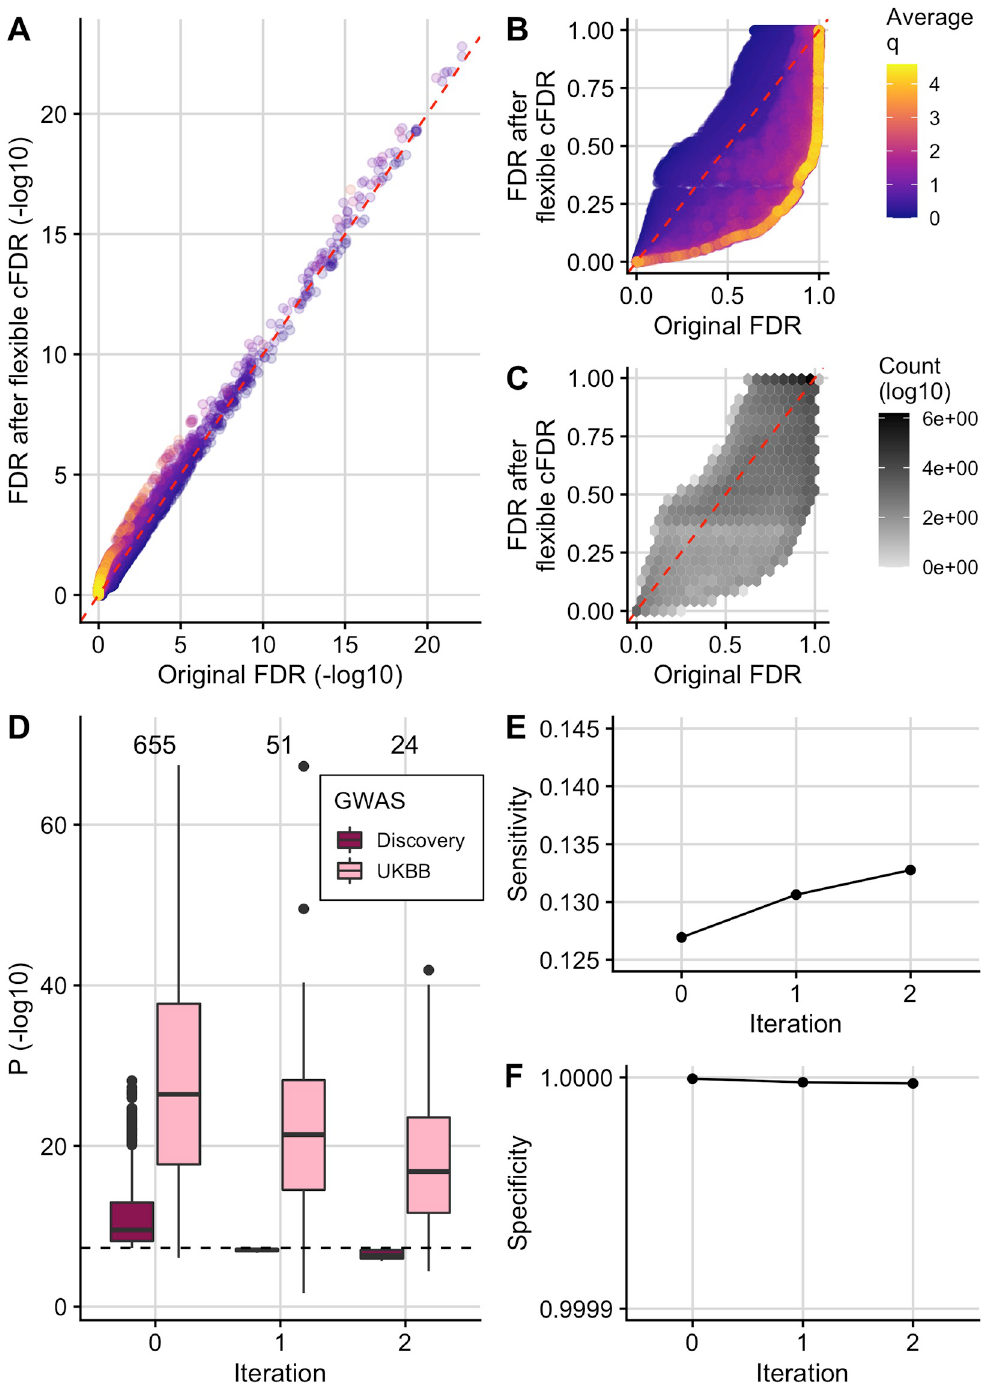
Fig 3. Using Flexible cFDR to leverage H3K27ac data with asthma GWAS p -values. (A) (-log 10 ) FDR values after 2 iterations of Flexible cFDR leveraging H3K27ac counts in relevant cell types against raw (-log 10 ) FDR values coloured by the average value of the auxiliary data across iterations. (B) As in A but non-log-transformed FDR values. (C) As in B but coloured by (log 10 ) counts of data points in each hexbin. (D) Box plots of (-log 10 ) p -values in the discovery GWAS and the UK Biobank data set for the 655 SNPs that were FDR significant in the original GWAS (Iteration 0), 51 SNPs that were newly FDR significant after iteration 1 of Flexible cFDR (leveraging average H3K27ac fold change values in lymphoid and CD56 cell types) and 24 SNPs that were newly FDR significant after iteration 2 of Flexible cFDR (subsequently leveraging average H3K27ac fold change values in lung tissue and CD14 + cells). Black dashed line at genome-wide